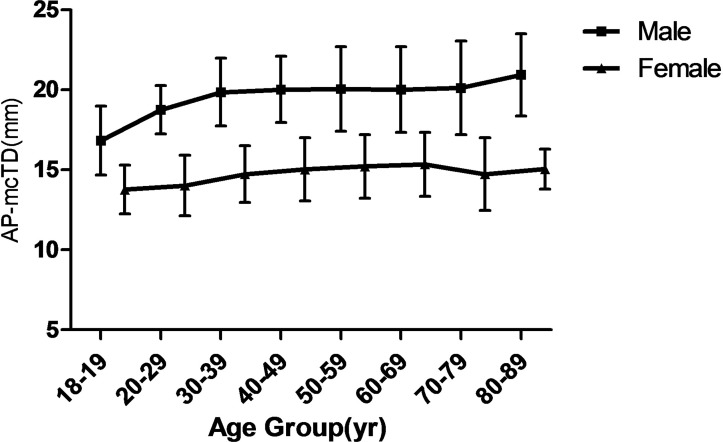
Mean AP-mcTD (Anteroposterior-Midclavicular tracheal diameter) of trachea from subjects with age 18 to 90.Values for each 10 year period were averaged.